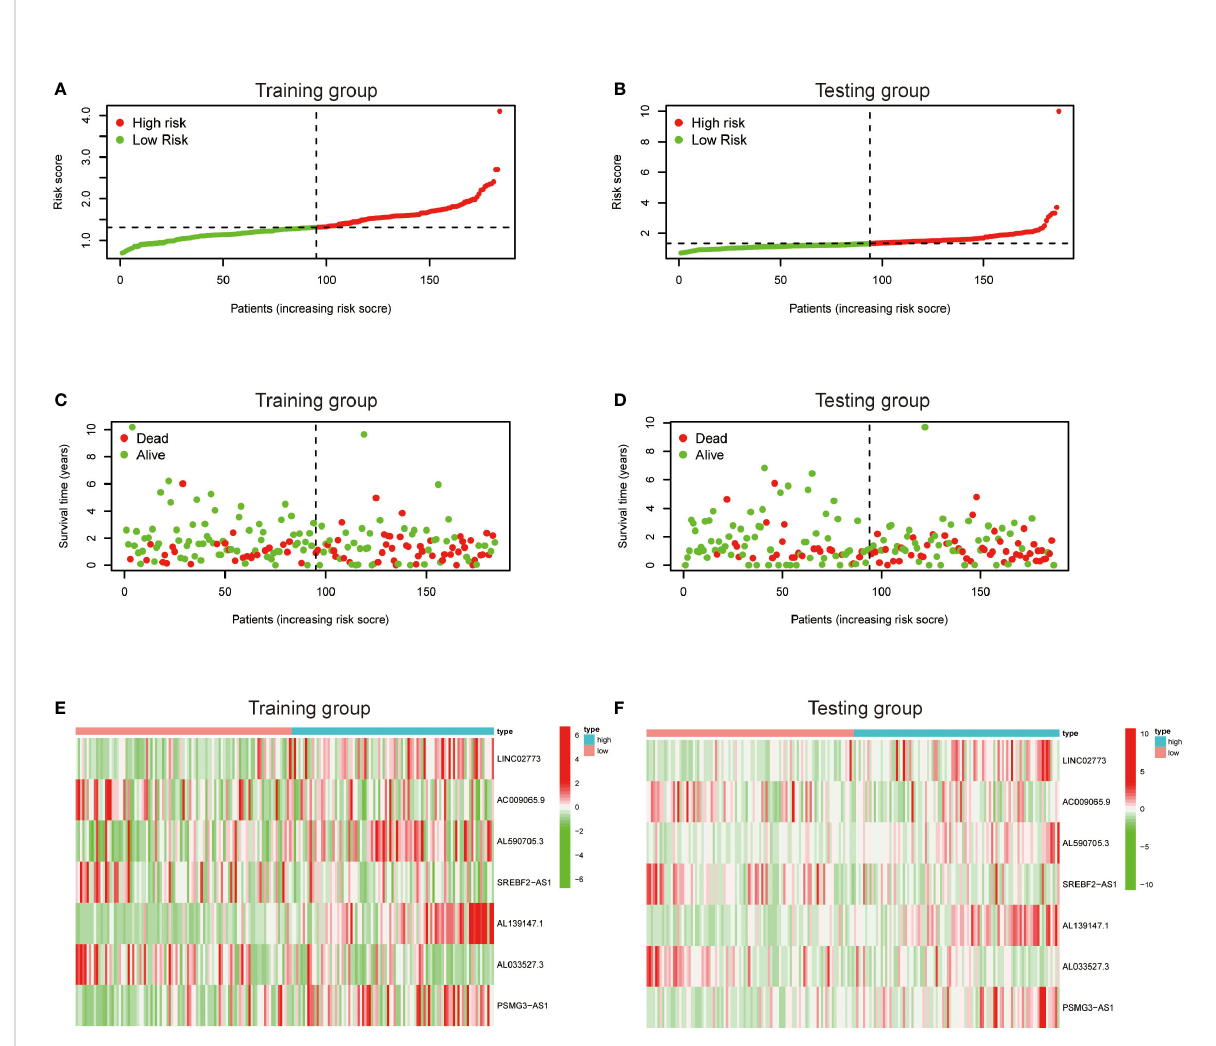
FIGURE 5 Prognostic value of the risk score model. (A, B) Patterns of survival status and survival time in the training and testing group. (C, D) Distribution of metabolic lncRNAs risk score model in the high- and low-risk groups plotted in training and testing set. (E, F) Heatmap showed the expression standards of the seven prognostic lncRNAs of training and testing